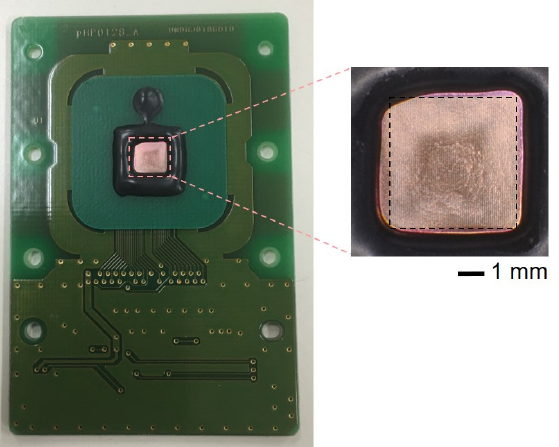
Figure 4 . Optical microscopic image of a redox-type label − free ATP image sensor. The sensor area for ATP detection is indicated with a black dash line.